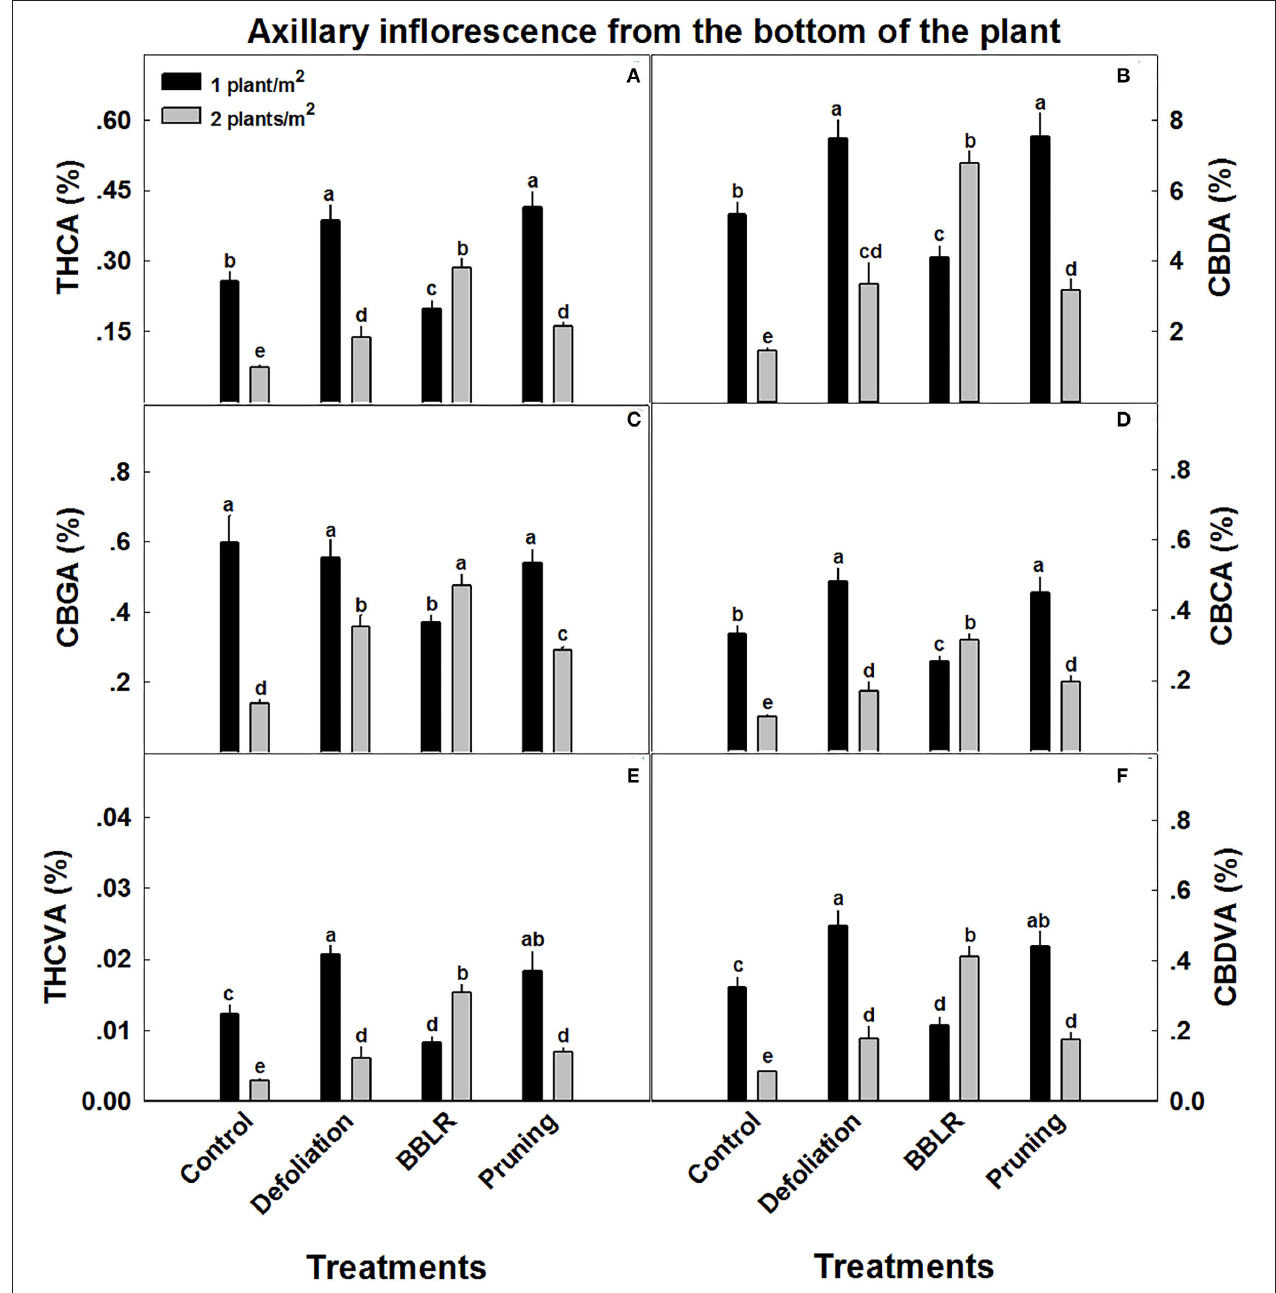
FIGURE 4 | Cannabinoid concentrations in axillary inflorescences from the lowest branch on the plant, close to the point of emergence from the main stem. The cannabis plants were grown under two densities (1 or 2 plants m − 2 ) and four architectural modulation treatments. Cannabinoids detected include THCA (A) , CBDA (B) , CBGA (C) , CBCA (D) , THCVA (E) , and CBDVA (F) . The results are mean and SE ( n = 6). Different letters above the bars represent significant differences between treatments by Tukey HSD test at α = 0.05. “BBLB” removal of leaves and branches from the bottom part of the